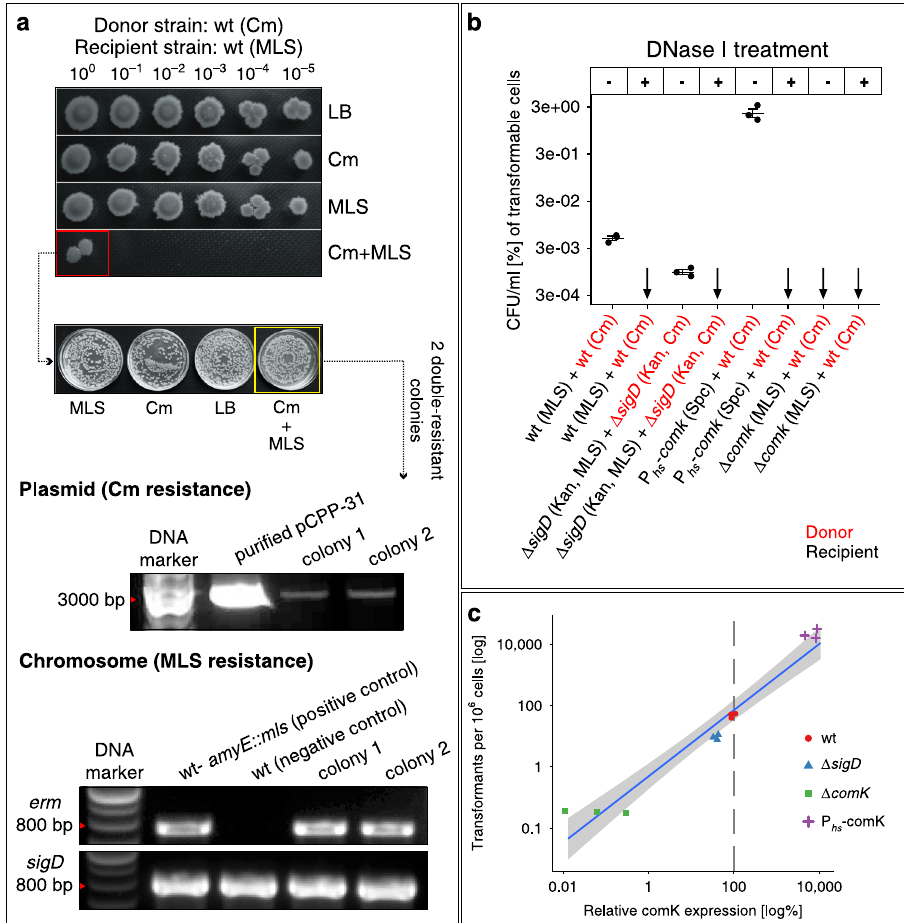
Fig. 4 Non-conjugative plasmid DNA transfer. a The donor (LK1925, wt containing the Cm resistance gene on plasmid pCPP31-Y1) and recipient (LK1922, wt harboring the MLS resistance gene on chromosomal DNA) strains were grown separately overnight. The following day, both strains were diluted to an initial OD 600 = 0.05, mixed 1:1, and cultivated for 4 h at 37 °C. The mixture was then serially diluted into fresh LB medium and 2 μ l were spotted on LB agar (control) and LB agar containing appropriate antibiotics (Cm-donor selection, MLS-recipient selection, Cm + MLS-cells with both antibiotic resistance genes). The cells were allowed to grow for 18 h at 37 °C. Only the mixture with the highest initial density then produced double-resistant cells. This colony was subsequently diluted into fresh LB medium to OD 600 = 0.05 and 100 μ l were plated on LB agar dishes with or without Cm, MLS or Cm + MLS. We detected many double-resistant colonies on the Cm + MLS agar dish (yellow square) and for two of them we con fi rmed the presence of the two resistance genes by plasmid isolation (the dominant supercoiled form of the plasmid is shown) and PCR of the chromosomally-located erm (MLS) resistance gene (primers against the sigD gene were used as a control). As the DNA marker we used GeneRuler DNA Ladder Mix (Thermo Scienti fi c). All experiments were conducted in three biological replicates with similar results. b Donor (LK1925-wt or LK1944- Δ sigD ) and recipient (LK1925-wt; LK2317-P hs - comK [hs, hyperspank]; LK1940- Δ sigD or LK2380- Δ comK ) strains were grown separately overnight, then diluted to an initial OD 600 = 0.05, treated or not treated with DNase I, and mixed in a 1:1 ratio. The mixtures were inoculated into fresh LB medium (to an initial OD 600 = 0.05) without antibiotics and gently shaken. After 4 h, bacteria were harvested and diluted to an OD 600 = 0.5. 100 μ l of each mixture was plated on LB agar dishes with appropriate antibiotic combinations, based on antibiotic resistance genes in donor/recipient. The combinations are speci fi ed in parenthesis after each strain below the graph. The dishes were incubated overnight at 37 °C and then CFU/ml were counted. Data are presented as mean values ± SEM, n = 3 biological replicates per condition shown as individual dots. Black arrows indicate zero values in all three biological replicates. All differences between DNAase(-) and DNase( + ) conditions in wt, Δ sigD and P hs - comK are statistically signi fi cant as well as all pairwise differences between the DNase(-) conditions (all p < 0.001, ANOVA adjusted with Tukey ’ s HSD, two-sided). c Correlation between the number of transformants per 10 6 cells and comK expression (determined by RT-qPCR). For display purposes we added 1 to all raw transformation counts. The blue solid line is the maximum likelihood linear fi t, the shaded gray area represents the 95% con fi dence interval of the fi t. The vertical dashed line indicates the wt expression against which the samples were normalized